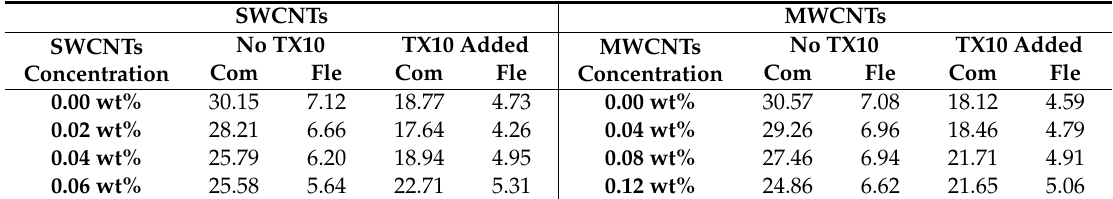
Table 10. Strength properties of SWCNTs and MWCNT-added specimens after 28 days of